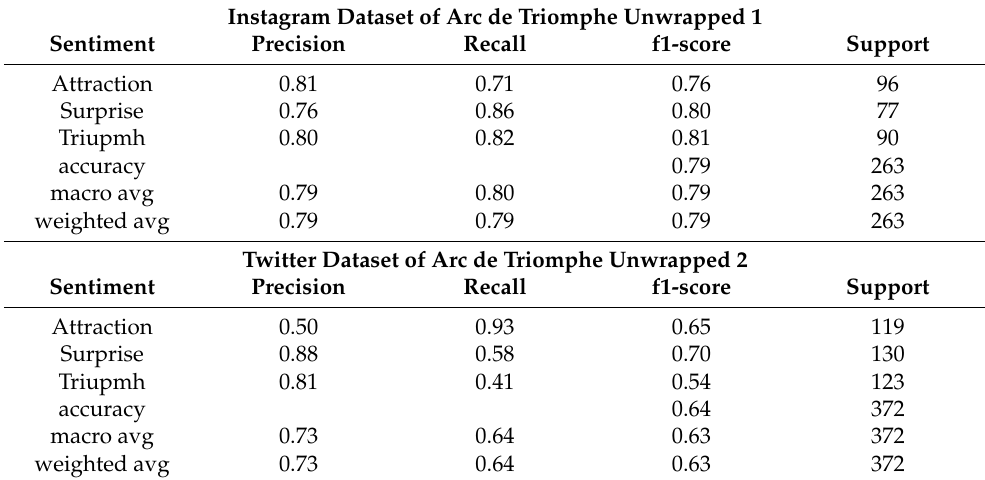
Table 5. Outcome evaluation by the classification